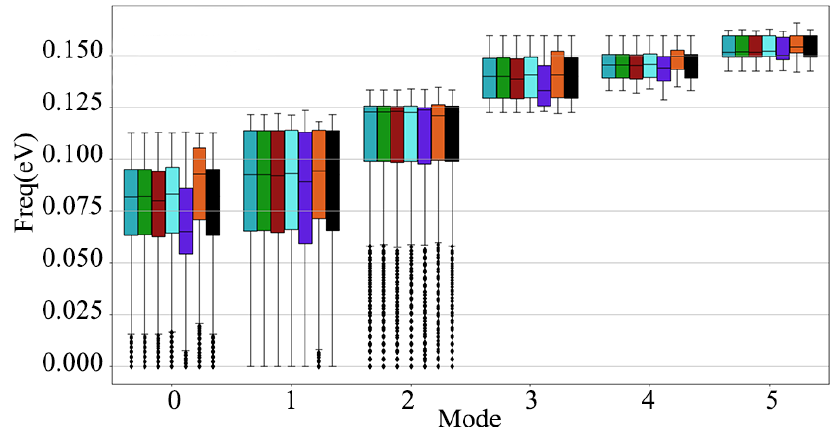
Figure 7. Frequency box plots of 3 acoustic branches and 3 optical branches of diamond, after applying different electric field intensities along the [111] crystallographic direction.